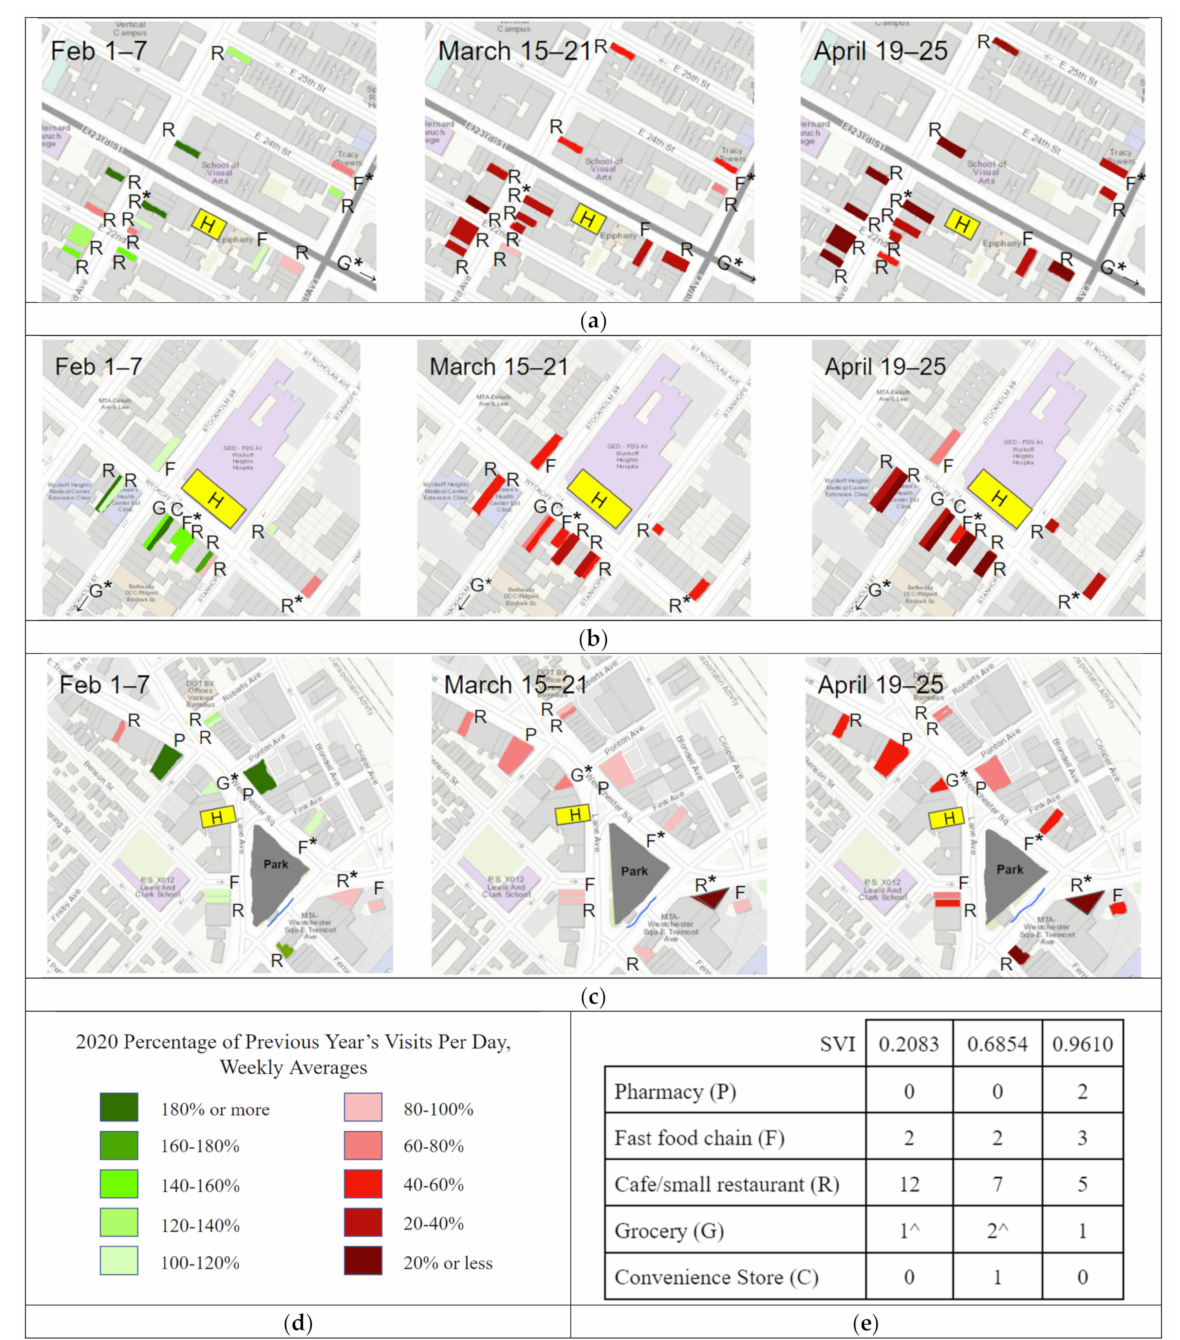
Figure 5. The 2020 percentage of the 2019 year’s visits per day for a set of businesses near 3 healthcare facilities (weekly averages). R, cafe or small, independent restaurant; G, deli or grocery; F, national fast-food chain; H, healthcare facility; * indicates that a business’s data was used in the following graph, ˆ indicates that a business was not pictured on the map, but it was nearby and included in the total set of POIs listed in the sub-captions. ( a ) 23rd St CityMD: Manhattan, 10,010; 15 POIs; SVI = 0.2083; ( b ) Wyckoff Heights Medical Center: Brooklyn, 11,237; 12 POIs; SVI = 0.6854; ( c ) Westchester Square CityMD: The Bronx, 10,461; 11 POIs; unweighted SVI = 0.9610; ( d ) legend for sub-figures ( a – c ); ( e ) facilities per study